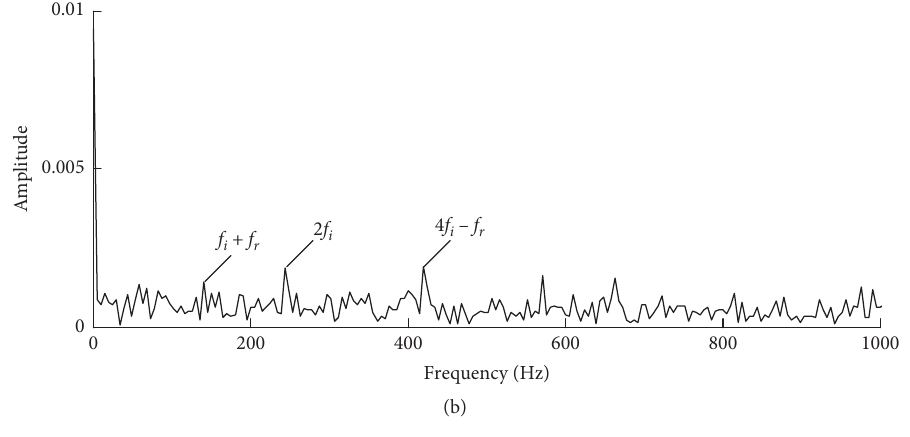
Figure 18: EEMD-TQWT decomposition result of inner race fault.